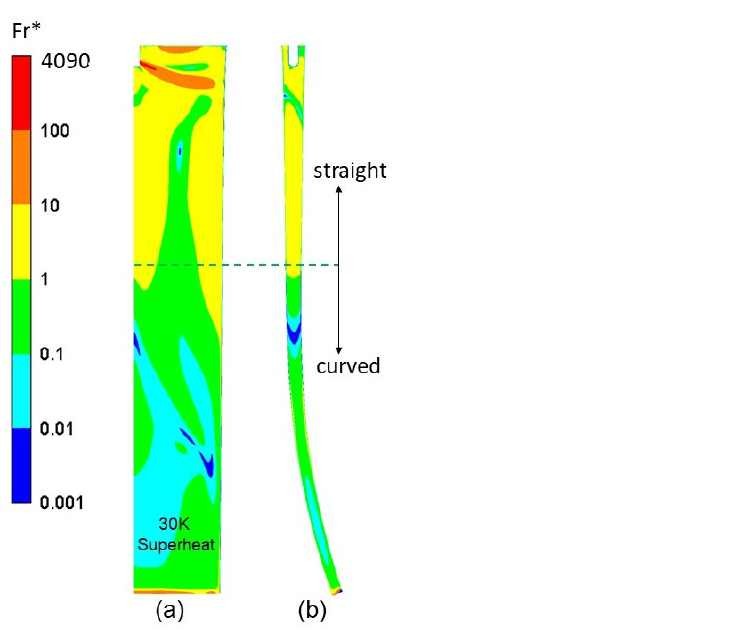
Figure 12. Modified Froude number distribution for 30 K superheat: ( a ) on the transverse center plane and ( b ) on the longitudinal center symmetry